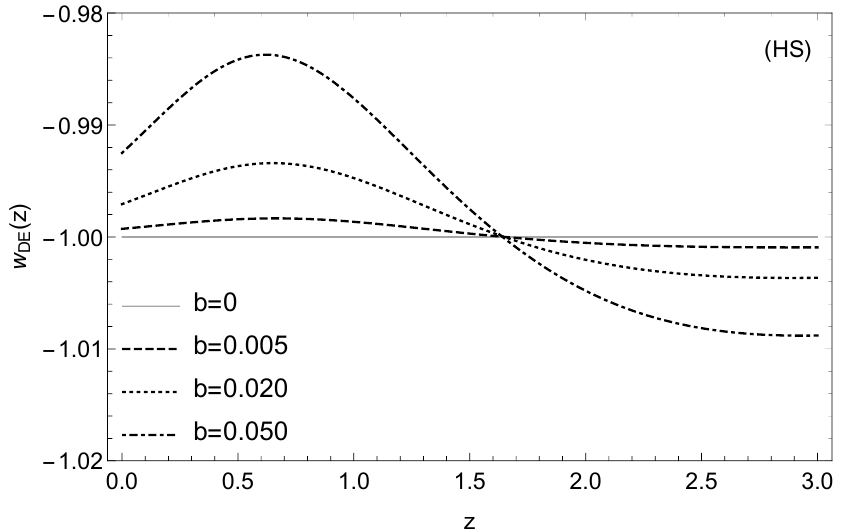
Figure 1. The evolution of the effective DE equation of state w DE ( z ) for the HS model for Ω m0 = 0.3, n = 1 and various values of the b parameter which controls the deviations from the Λ CDM model (see Ref. [97]), with b ∈ [ 0,0.05 ] . The equation of state crosses w DE = − 1 at z ∼ 1.65, while at early times, we have 1 + w DE < 0, thus violating the SEC. Image from Ref.